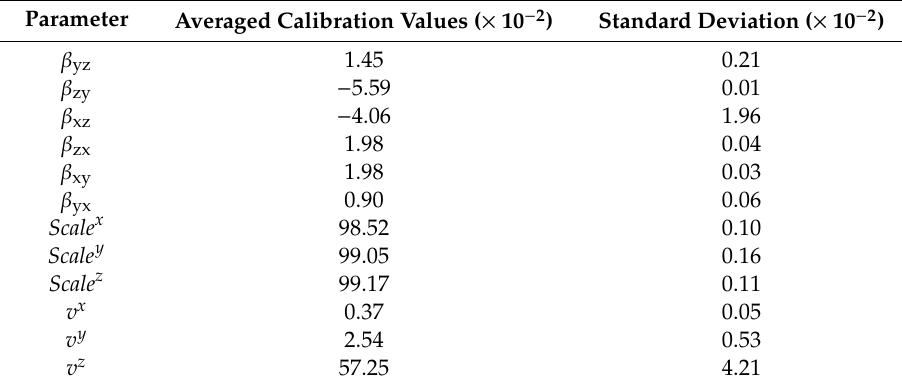
Table 3. Mean and variance of MEMS-IMU error parameters.